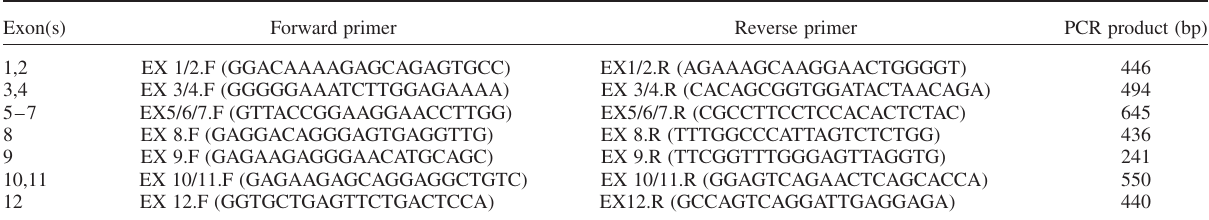
TABLE I Primers used for amplification and sequencing of Prss16 in NOD and NON